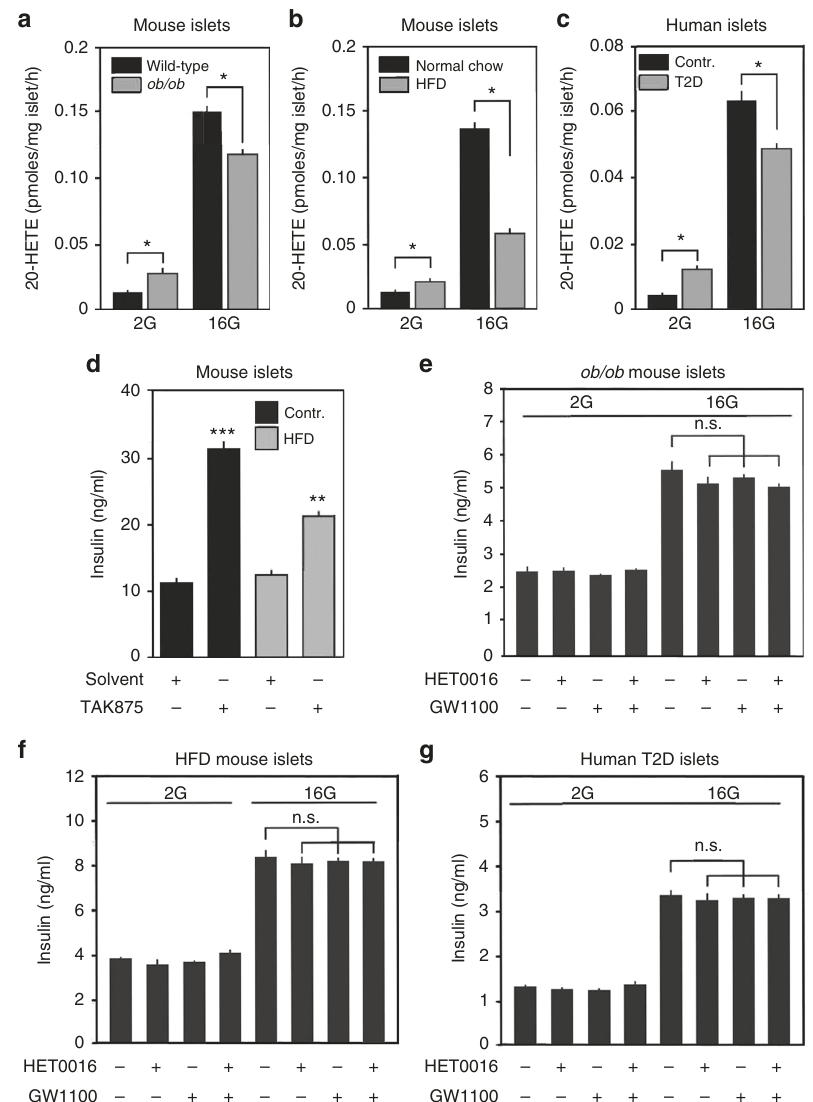
Fig. 5 20-HETE/FFAR1-mediated stimulation of GSIS is strongly reduced in type-2 diabetes. a – c 20-HETE release from islets isolated from lean wild-type and obese leptin-de fi cient mice ( ob/ob ) at an age of 20 weeks ( a ) from mice fed normal chow or HFD for 23 weeks ( b ) or from non-diabetic (contr.) and type-2 diabetic human donors (T2D) ( c ) in the presence of 2.8 (2G) and 16.7 mM (16G) of glucose. d Effect of the speci fi c FFAR1 agonist TAK-875 (30 µ M) on GSIS at 16.7 mM of glucose in islets from non-diabetic mice fed normal chow diet (control diet) and from diabetic mice fed HFD for 23 weeks (high-fat diet). e – g Effect of HET0016 (30 µ M) and GW1100 (30 µ M) on insulin secretion from murine islets prepared from leptin-de fi cient mice ( ob/ob ) ( e ), mice fed a HFD ( f ), or from human islets prepared from two type-2 diabetic (T2D) donors ( g ) kept in 2.8 (2G) and 16.7 mM (16G) of glucose. Shown are mean values ± s.e.m., n = 6 ( a – c ), n = 9 ( e – g ); *P ≤ 0.05; ** P ≤ 0.01; *** P ≤ 0.001 (Student ’ s two-tailed t signi fi cantly increased ef fi cacy compared to other long-chain fatty by GW1100 (Fig. 2g). The maximal effect of 20-HETE on GSIS acids described as FFAR1 agonists so far. was signi fi cantly higher than the maximal effect of palmitic acid (Fig. 2c, e), which corresponds to the higher ef fi cacy of 20-HETE- induced FFAR1 activation (Fig. 1a, b). 20-HETE stimulates GSIS via FFAR1 . We then tested in isolated mouse and human islets, whether 20-HETE was able to increase insulin secretion at low and high glucose concentrations. 20- HETE promoted GSIS in islets to a similar degree as the mus- carinic receptor agonist carbachol (Fig. 2a). 20-HETE con- centration-dependently promoted GSIS with an EC50 of about 10 µ M, being slightly more potent than palmitic acid (Fig. 2b – e). The effect of 20-HETE was mediated by FFAR1, since in islets from Ffar1-de fi cient mice 20-HETE had no effect on GSIS while the effect of carbachol was unchanged (Fig. 2f). In addition, 20-